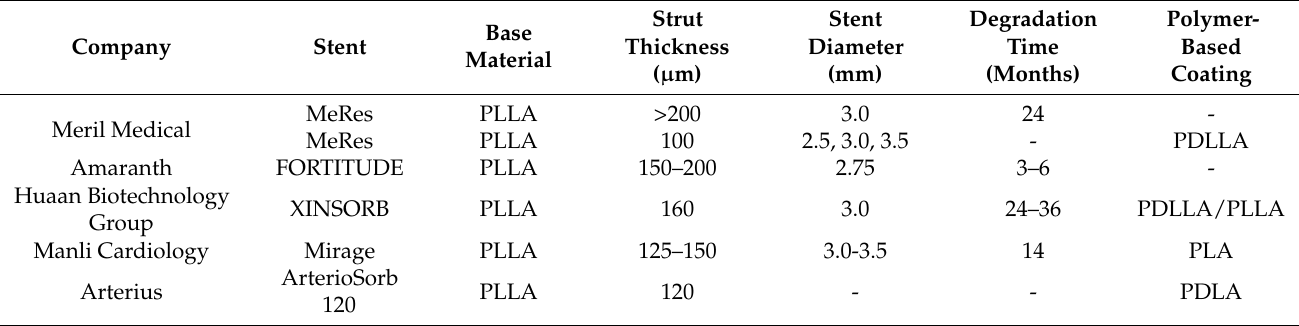
Table 3. Stents coated with